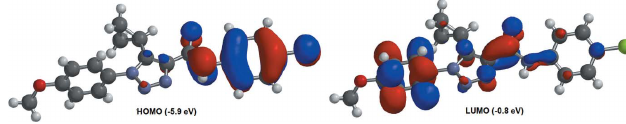
Figure 5 Frontier molecular orbital energies.